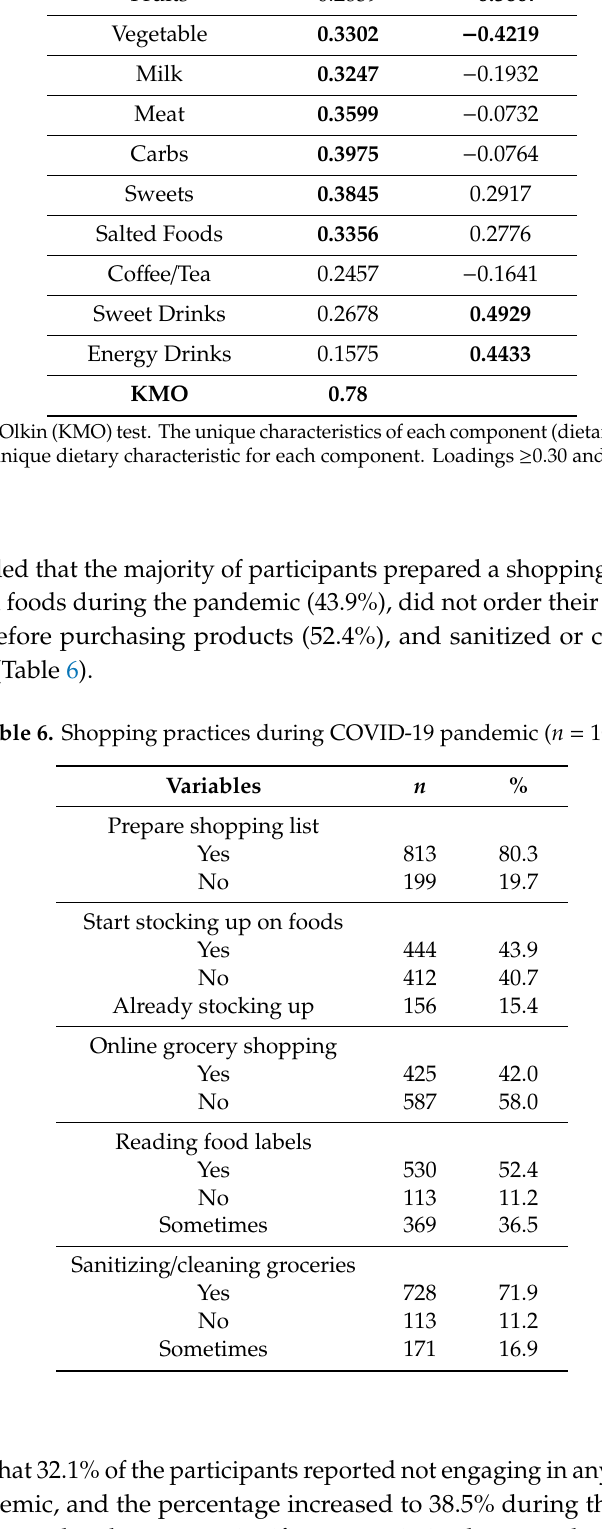
Table 5. Component loading for the two major dietary patterns of the participants during COVID-19. Food Groups